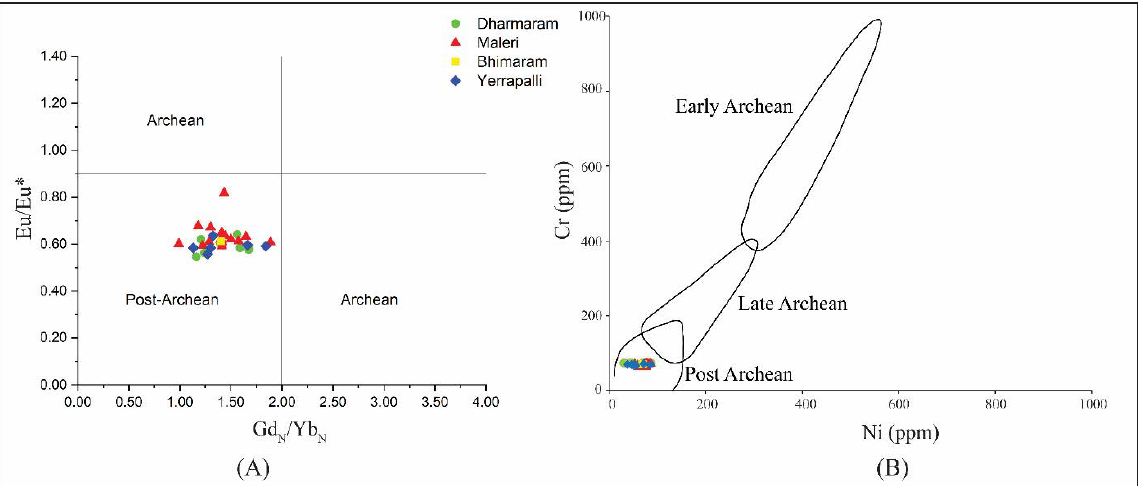
Figure 10. ( A ) Plot of Eu/Eu* versus (GdN/YbN) [81] and ( B ) plot of Cr versus Ni [47] for mudstone samples of the Yerrapalli, Bhimaram, Maleri and Dharmaram formations.